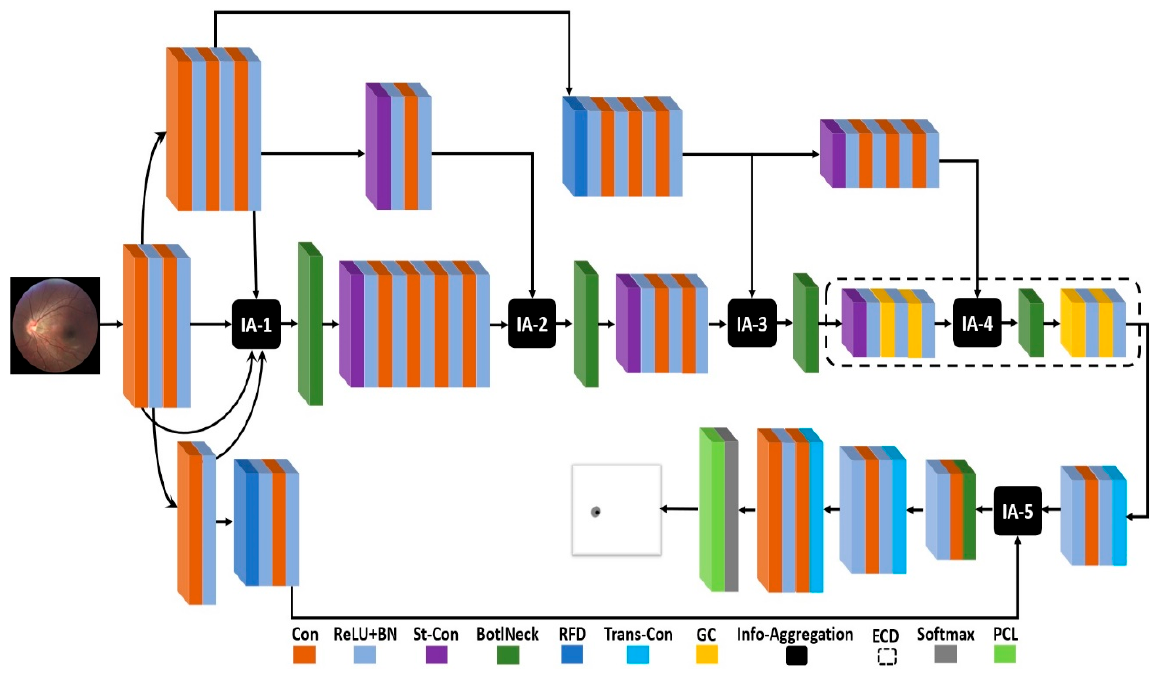
Figure 4. The architecture of the proposed FEDS-Net (Con: Convolutional layer; BN: Batch normalization layer; St-Con: Strided convolutional layer; BotlNeck: Bottleneck layer; RFD: Rapid feature downsampling; Trans-Con: Transposed convolutional layer; GC: Grouped convolutional layer; ECD: Efficient convolutional depth; PCL: Pixel classification layer; IA: Information aggregation).